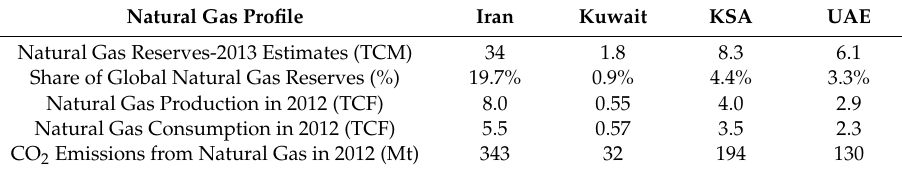
Table 2. Natural Gas reserves, production, consumption and related emissions [3]